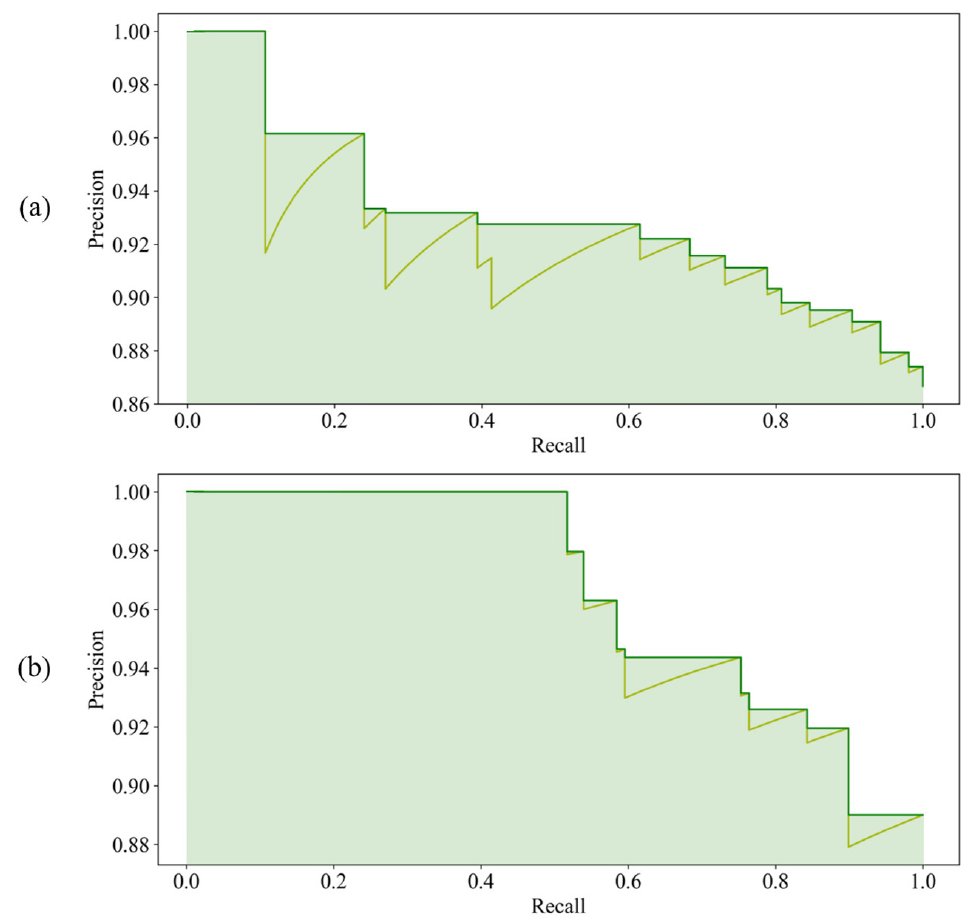
Figure 14. AP curves of the detection results of ( a ) EfficientDet-D0 with AP 0.924 and ( b ) Faster R-CNN with AP 0.964.